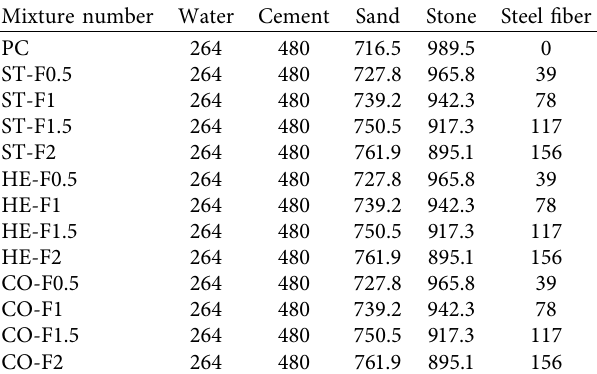
Table 4: Mixture proportions (kg/m 3